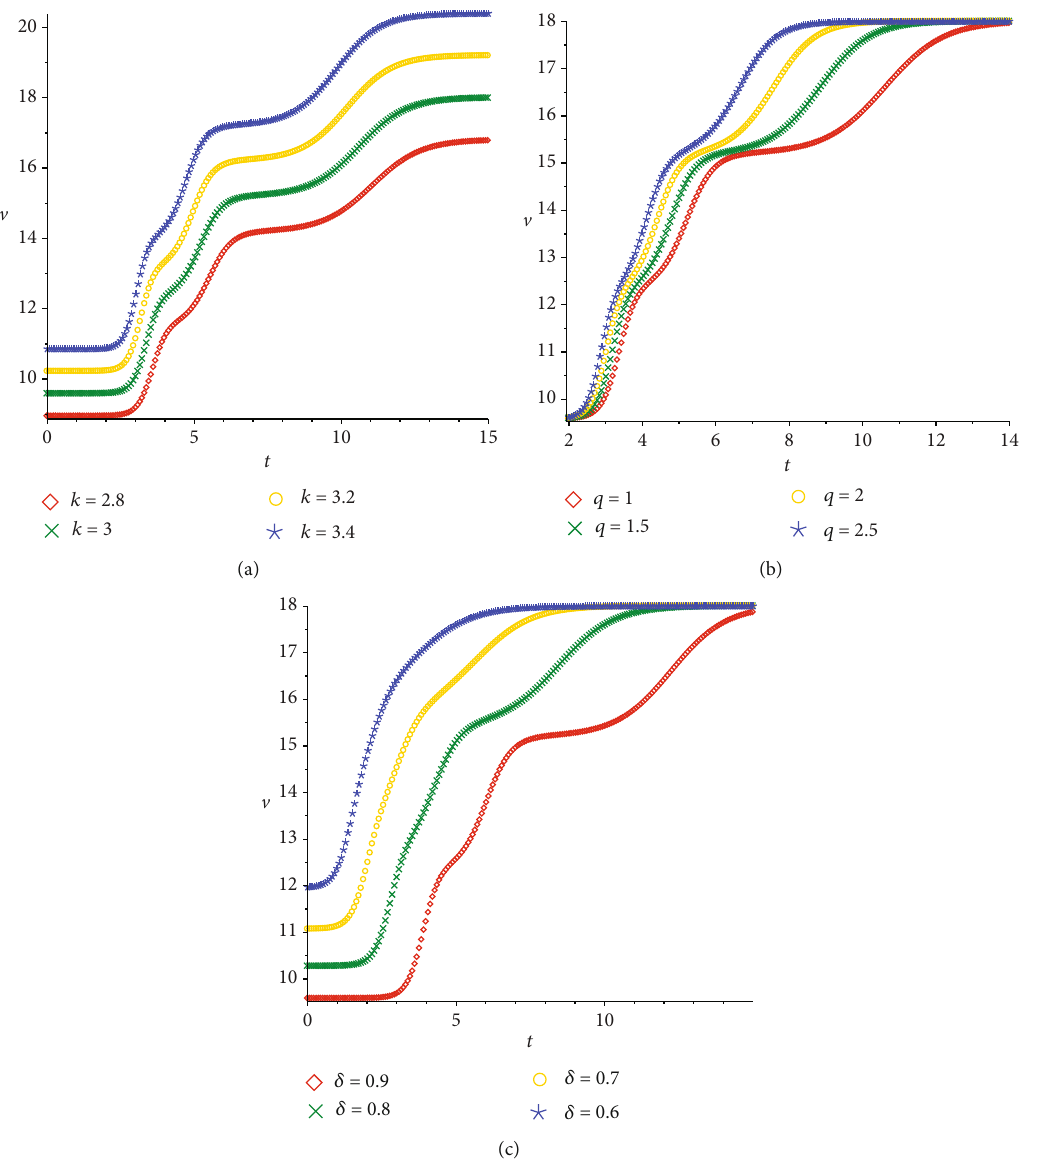
Figure 7: Three shock waves for l